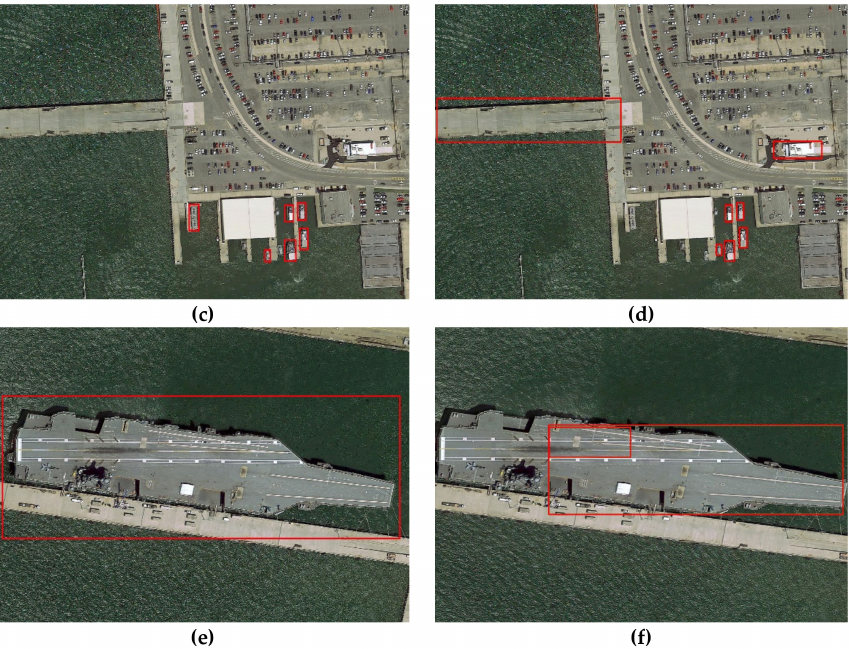
Figure 24. The detection results of the cascading model on a board area image. The result of our method in shown in ( a ) the purple box in ( a ) represents the area with 1024 × 1024, ( b ) is the enlarged image of the red box in ( a ), ( c ) is the same place with ( d ) and they are proposed by our method and the Faster R-CNN separately, and ( e ) is one example in ( a ) and ( f ) is the same ship that is conducted by the Faster